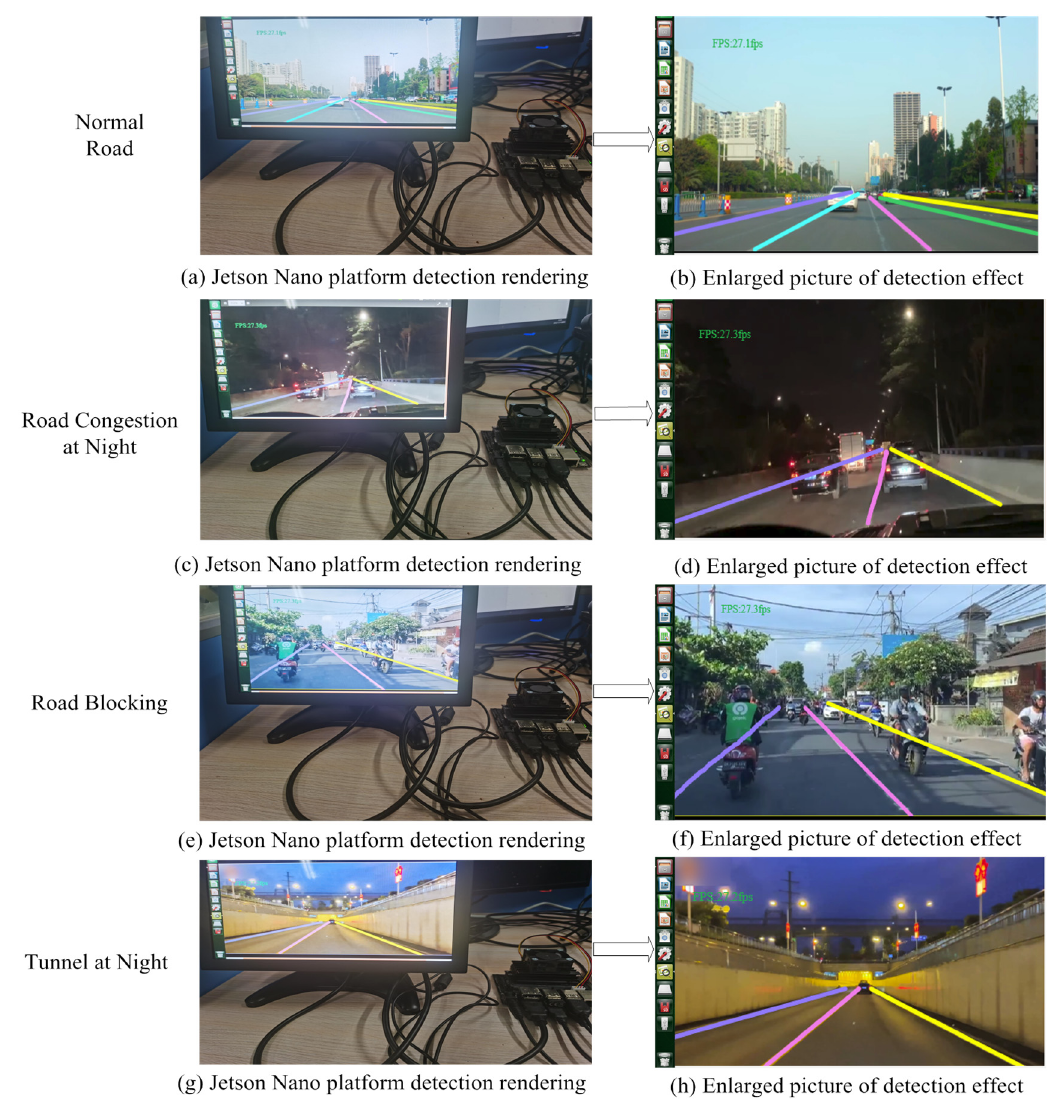
Figure 19. Mobile terminal detection rendering.